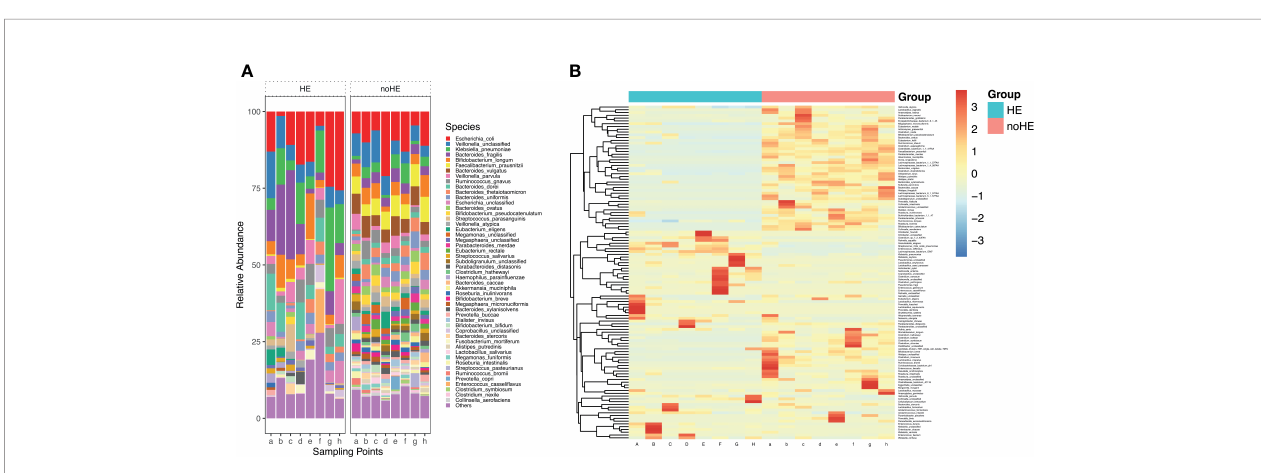
FIGURE 3 | Comparison of, and changes in, the gut microbiota (at the species level) in patients with and without HE. (A) Composition of gut microbiota in patients with and without HE. (B) Changes in the abundance of 119 species of bacteria in patients with (left side) and without (right side) HE after rifaximin administration. Horizontal coordinates denote sampling time points; a – h represent Day 1, Week 1, Week 2, Week 4, Week 6, Week 8, Week 10, and Week 12, respectively.